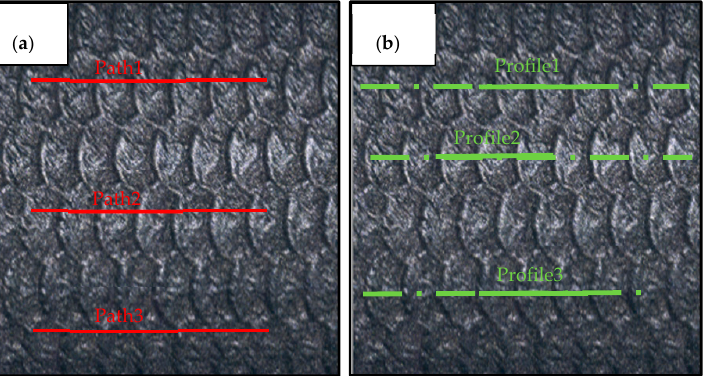
Figure 6. Roughness profile paths example ( a ), primary profile study paths example ( b ). Along with the linear roughness parameters, the areal average roughness ( S a ) was measured. Primary profiles analysis was performed choosing three profiles laying on the mid planes of the scale rows (Figure 6b). For each primary profile, the mean peak to valley distance ( ∆ pv meas ) was collected and distance among correspondent scales’ points ( dl sr , i ) was sampled three times (Figure 7a). The considered distance among correspondent scales’ points ( dl sr , meas ) for the analyzed profile was the average between the sampled ones. The final considered values for the analyzed scale pattern were then the average results among the three observed profiles. These distances were used to generate a prior assessment of the manufactured scales’ quality, comparing with the theoretical distances imposed by the 3D original model, respectively called ∆ pv theo and dl sr , theo (Figure 7b).